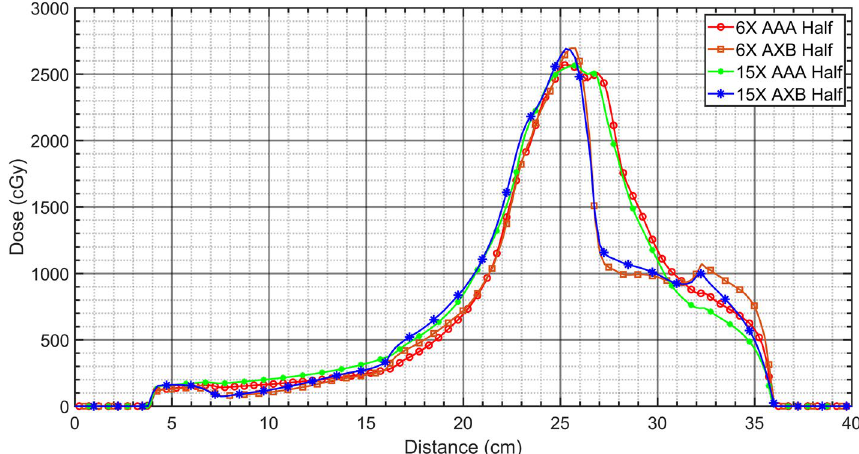
Figure 7. Comparison of dose profiles at the center of the PTV in the half arcs-based VMAT plans with different energies and caluation algorithms.